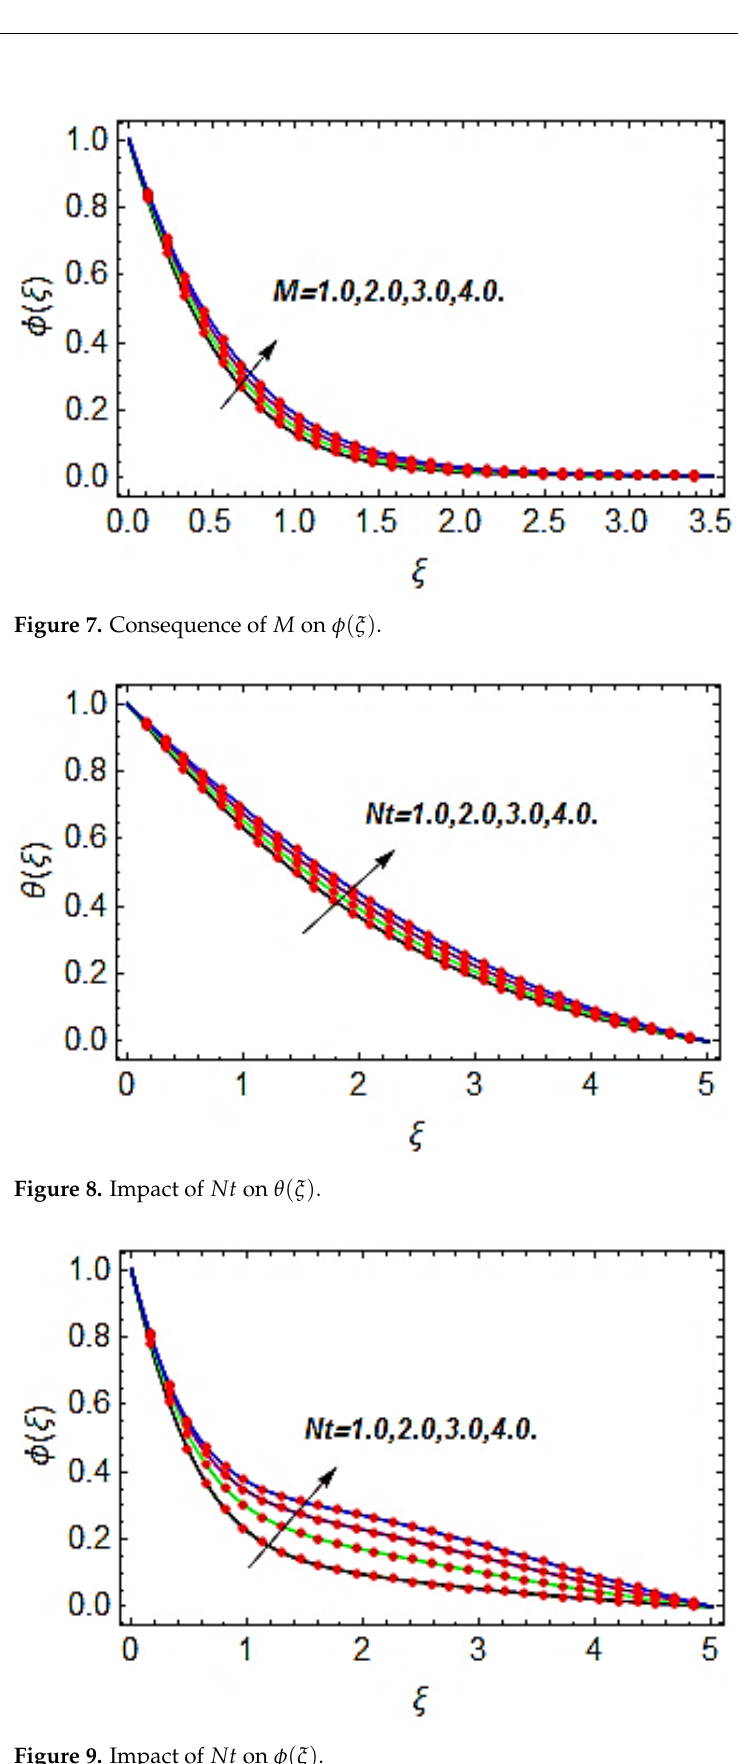
Figure 9. Impact of Nt on